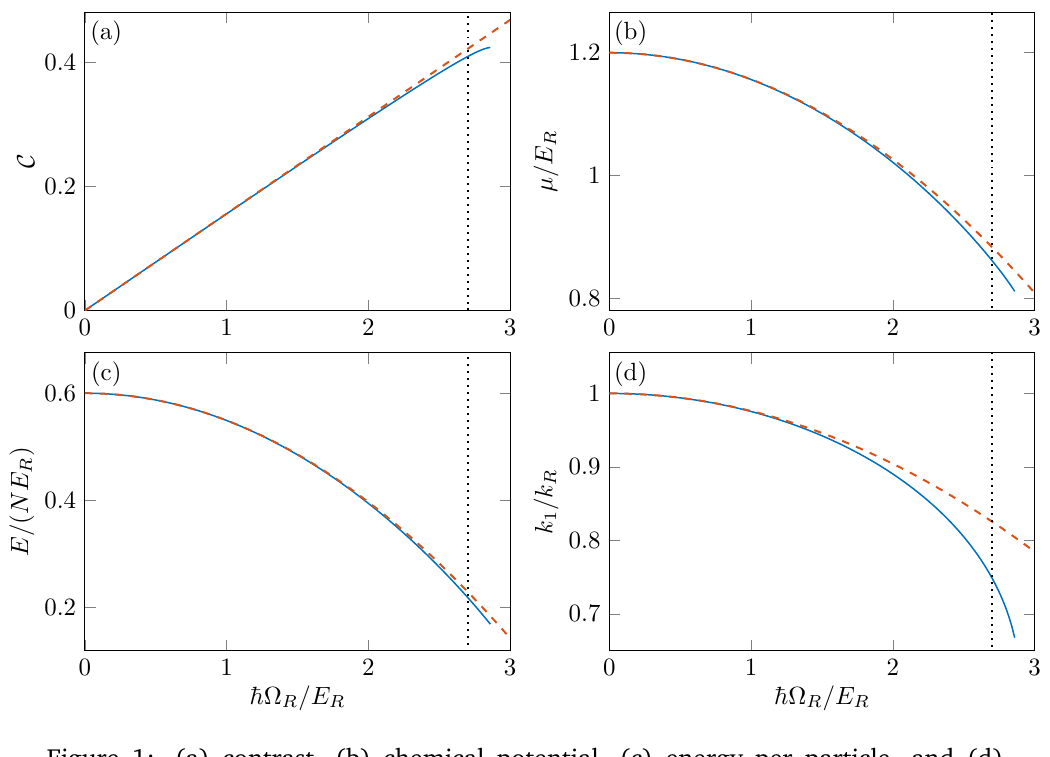
Figure 1: (a) contrast, (b) chemical potential, (c) energy per particle, and (d) wave vector in the stripe phase as functions of the Raman coupling Ω for a fixed R value of the density. The blue solid lines show the exact values determined numeri- cally, whereas the red dashed ones correspond to the perturbation results up to sec- / 4 E ond order in ħ h Ω . The interaction parameters are the same as in Ref. [ 36 ] : R R / E = 1.2, G / E = 0.32. As stated in the main text, for such values the first- G dd R ss R = 2.70 E order transition to the plane-wave phase occurs at ħ h Ω (vertical black R R = 2.85 E dotted lines), and the spinodal point at ħ h Ω R R